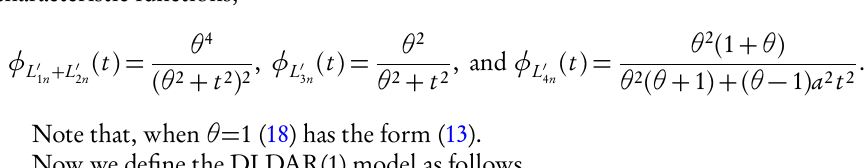
, i = 1, 2, 3, 4 are independent Laplace distributed random variables with the Here L ′ in characteristic